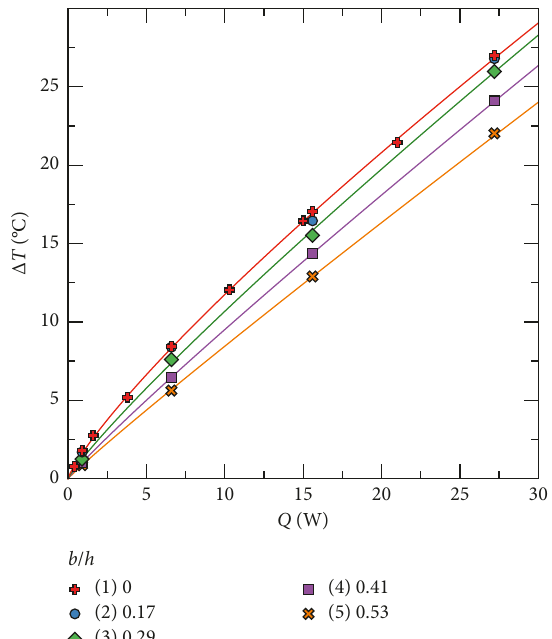
Figure 3: The temperature difference Δ T versus the heating power Q in the case of natural convection (1) and at vibrations with the amplitude b � 3 . 0 (2), 5.1 (3), 7.2 (4), and 9.2mm